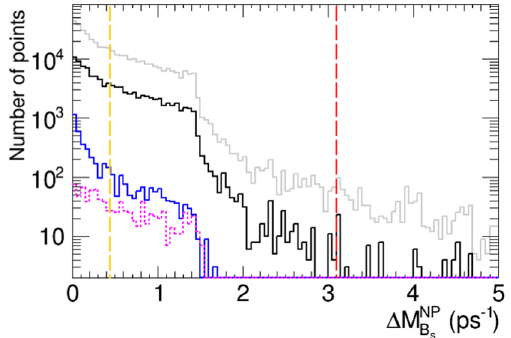
Fig. 11 Distribution of the contribution to the B s − B s mass differ- ence, (cid:3) M NP . The red dashed line shows the current experimental con- B s straint, and the yellow dashed line shows the prospective future sensi- tivity assuming that the uncertainty in the non-perturbative calculation can be reduced by a factor of 10. Grey histogram: all points passing the LHC mass and flavour constraints; black: also including current EDM limits; blue: including possible future proton EDM constraint, assum- ing a central value of zero; magenta: including possible future proton EDM measurement of ( 1 ± 0 . 025 ) × 10 − 27 e.cm